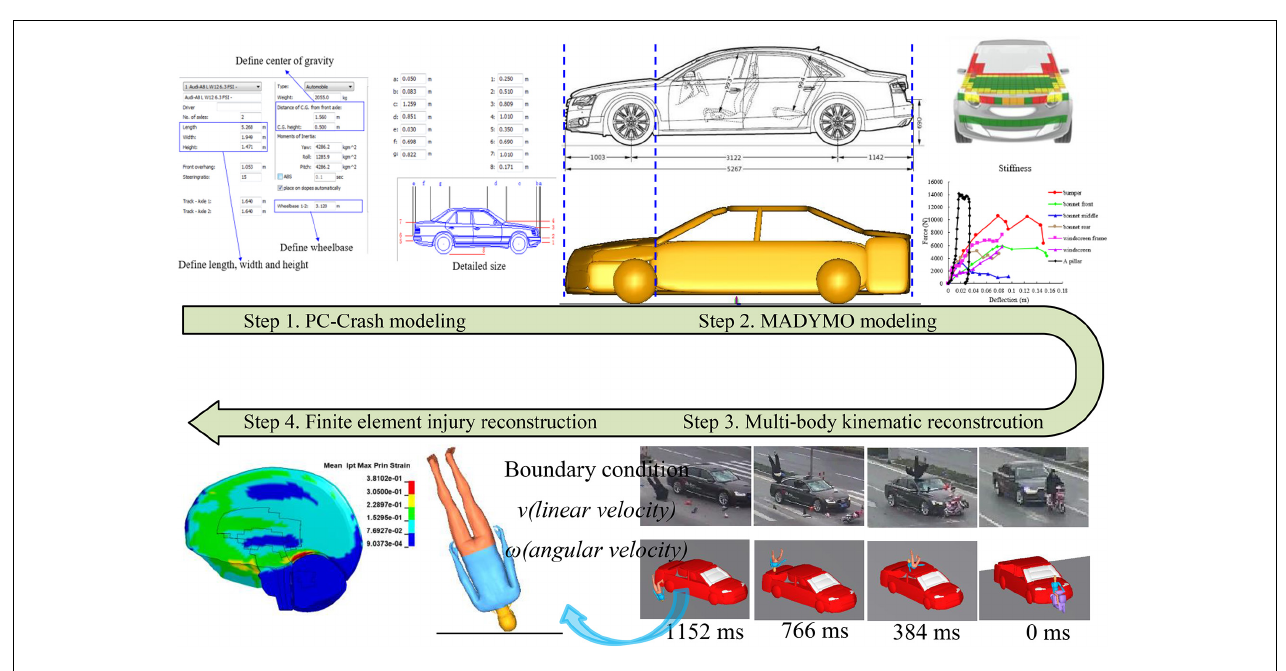
FIGURE 1 | The methodology was implemented for the accident